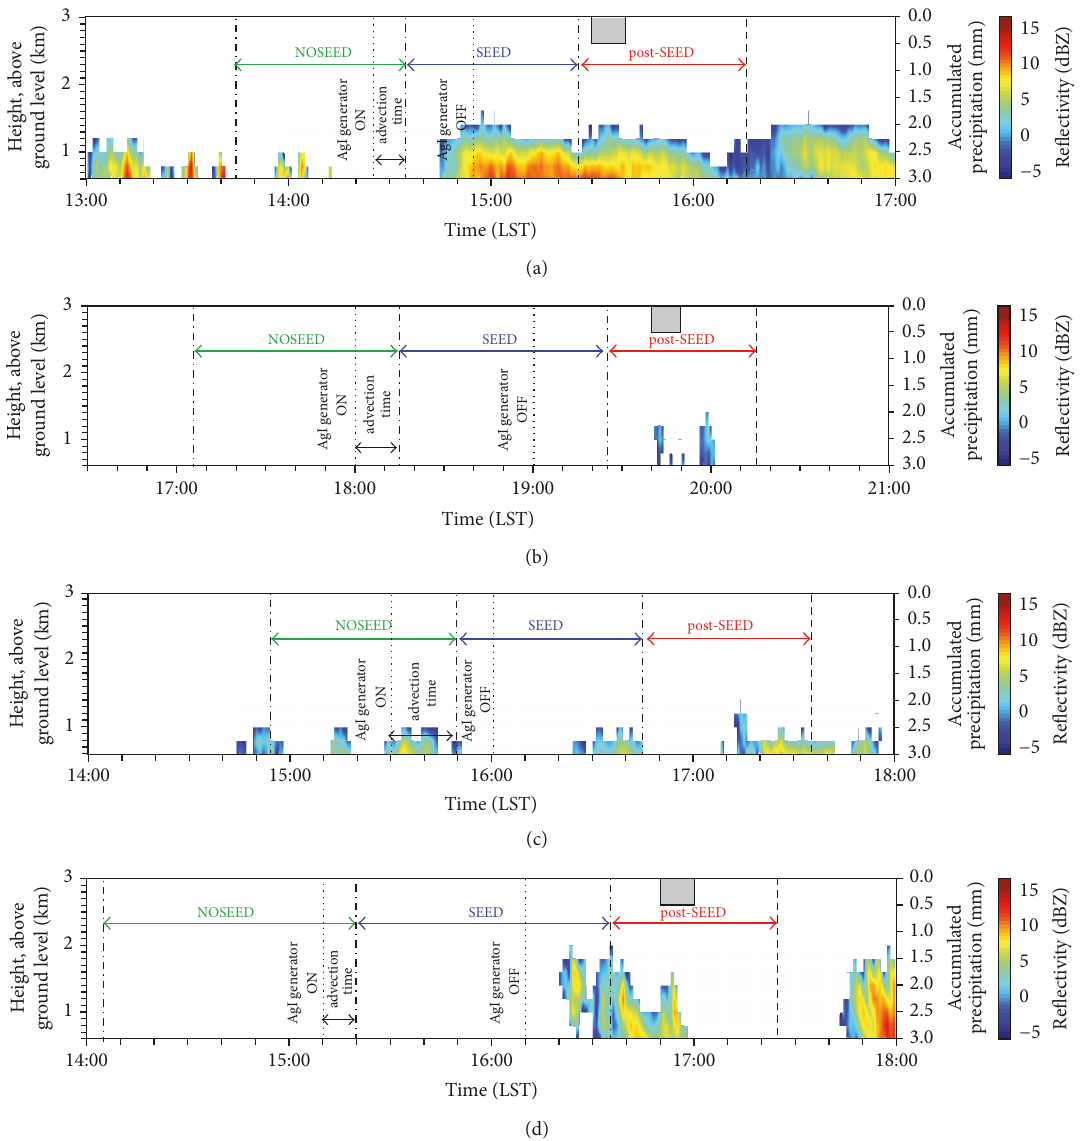
Figure 6: Time series of vertical reflectivity measured by micro rain radar (MRR, color shaded) and 10min accumulated precipitation (grey bar) from the rain gauge at YP for (a) EXP1, (b) EXP2, (c) EXP3, and (d) EXP4.